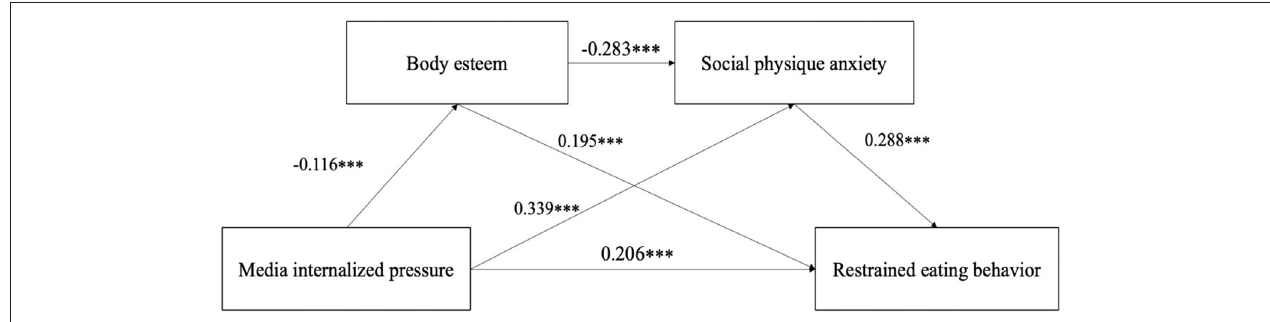
FIGURE 2 | Mediation effect analysis of body esteem and social physique anxiety between media internalized pressure and restrained eating behavior; *** p <